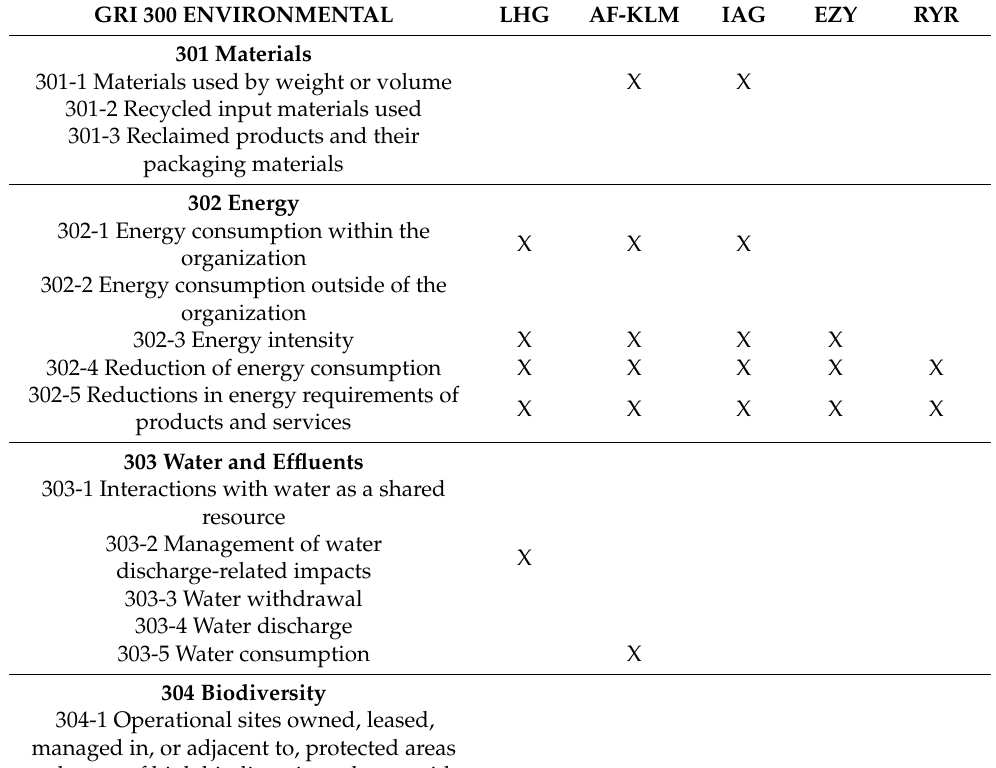
Table 4. Reported disclosures within GRI 300